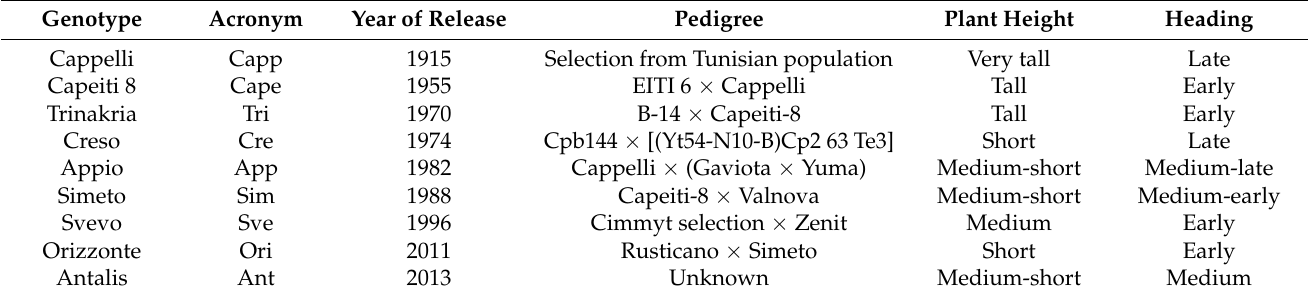
Table 1. Year of release, pedigree, plant height, and earliness of the nine genotypes of durum wheat used in the experiment.